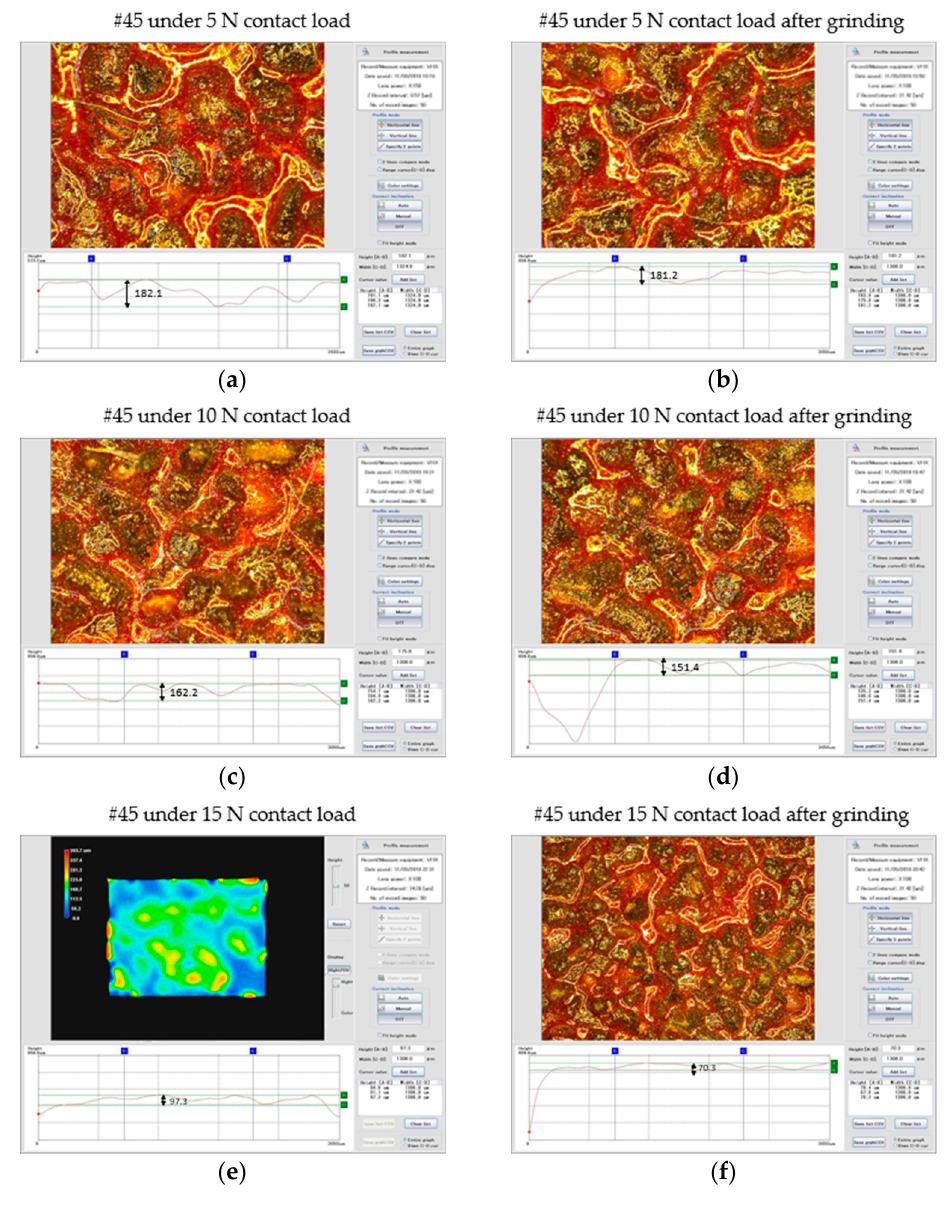
Figure 11. Abrasive height measurement example.